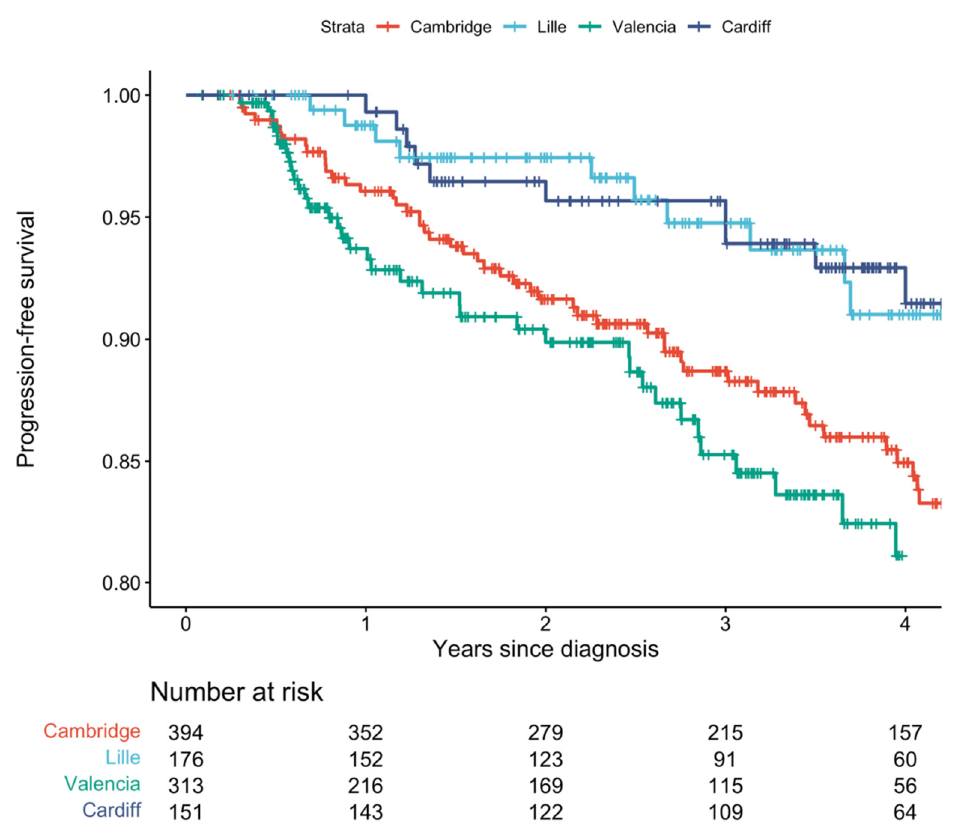
Figure 2. Kaplan–Meier curves for each centre’s cohort, with outcome being progression to Cam- bridge Prognostic Group 3 or worse. The multicentre model development cohort comprised men from Cambridge, Lille, and Valencia. The Cardiff cohort was used for external validation.